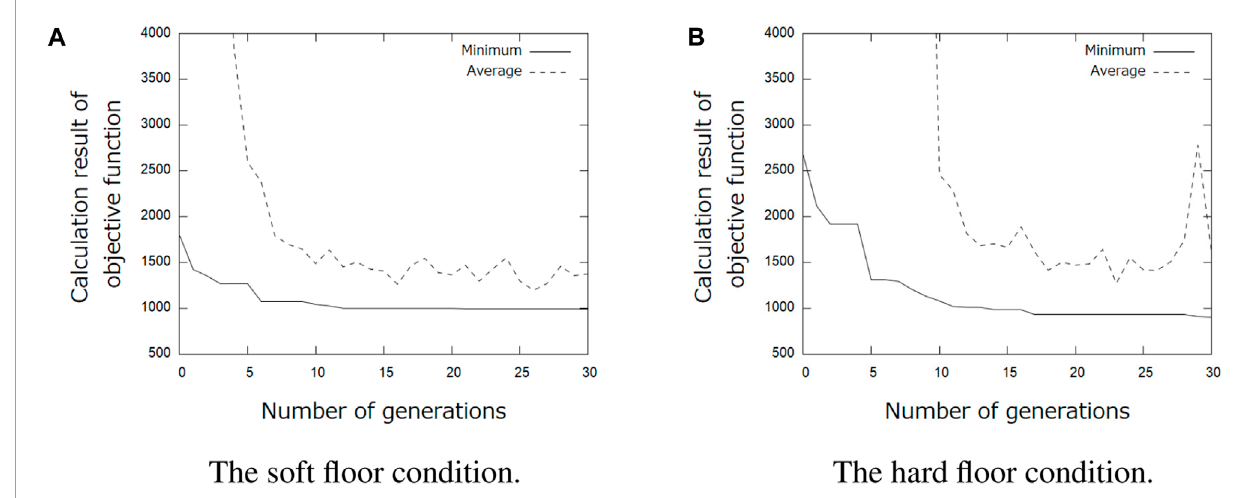
FIGURE 11 Change of objective function value during genetic algorithm (GA) execution.